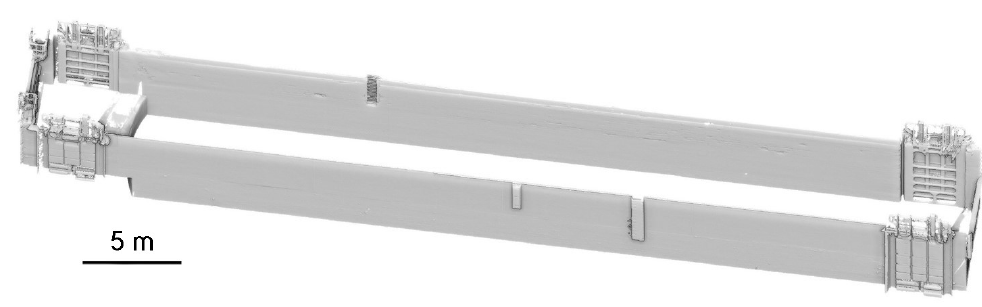
Figure 7. 3D laser model of the